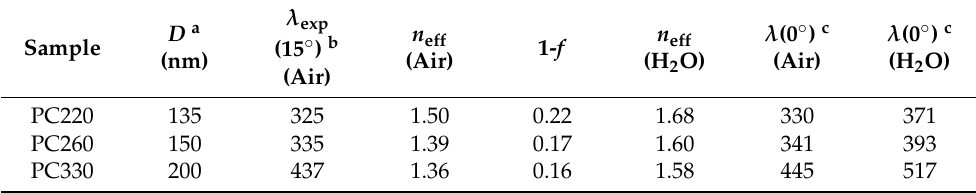
Table 1. Optical parameters for the TiO 2 inverse opal